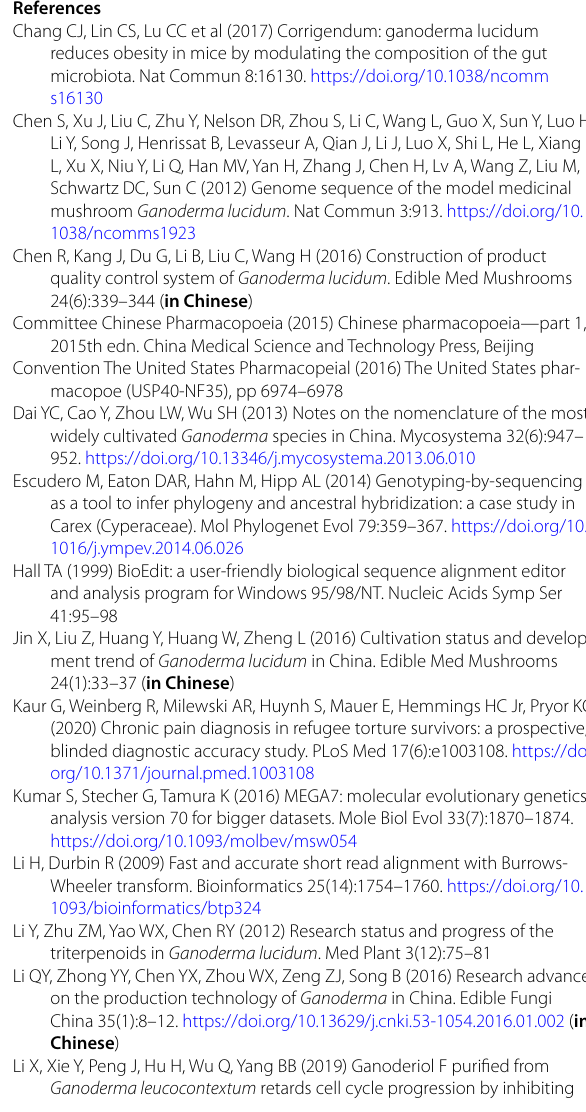
Additional file 1: Table S1. Collecting information of Lingzhi sample(strains and fruit body). Table S2. Table of Genomic electronic digestion assessment statistics. Table S3. Table of base information before and after filter. Table S4. Statistics table of reads filter information. Table S5. HQ clean Reads vs. Reference Genomes. Table S6. Statistical of SNP in samples’ chromosome. Additional file 2. Statistics of annotation results for each